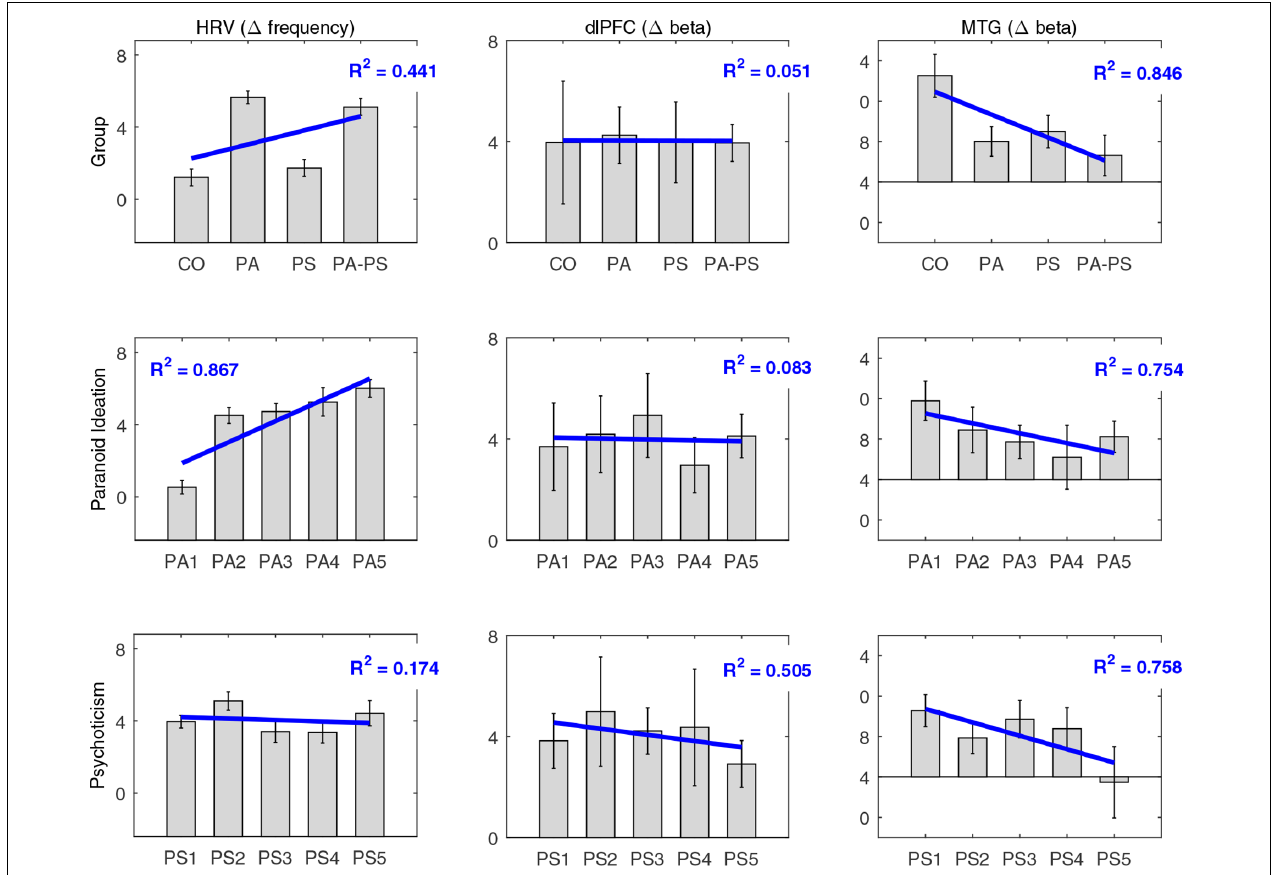
FIGURE 6 | Comparison of subscales. Comparison of the main effects of ‘group’ (CO, PA, PS, PA-PS) with the five original quintiles of the subscales ‘Paranoid Ideation’ (PA1–PA5) and ‘Psychoticism’ (PS1–PS5), for HRV, DLPFC, and MTG. Note that for simplicity, the plots are only shown for the difference between the negative and the neutral condition based on RT slow . Blue lines indicate the main effect and the corresponding fit expressed as the coefficient of determination ( R 2